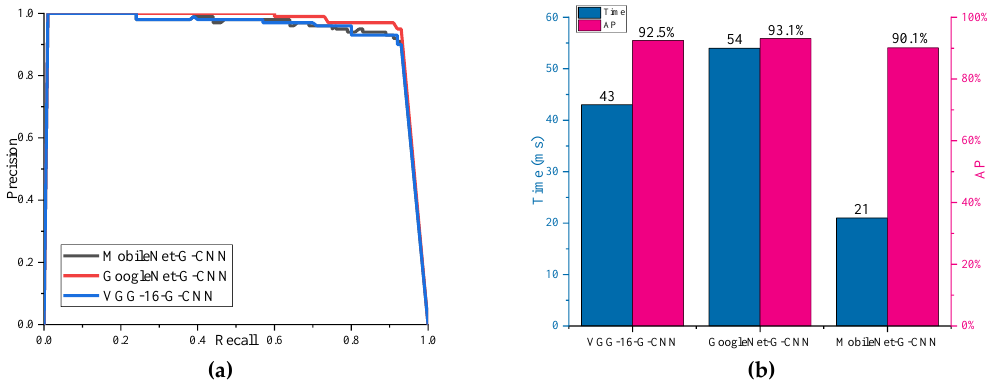
Figure 15. Different B-CNNs. ( a ) P-R curve; ( b ) AP and detection time. Figure 15. Di ff erent B-CNNs. ( a ) P-R curve; ( b ) AP and detection